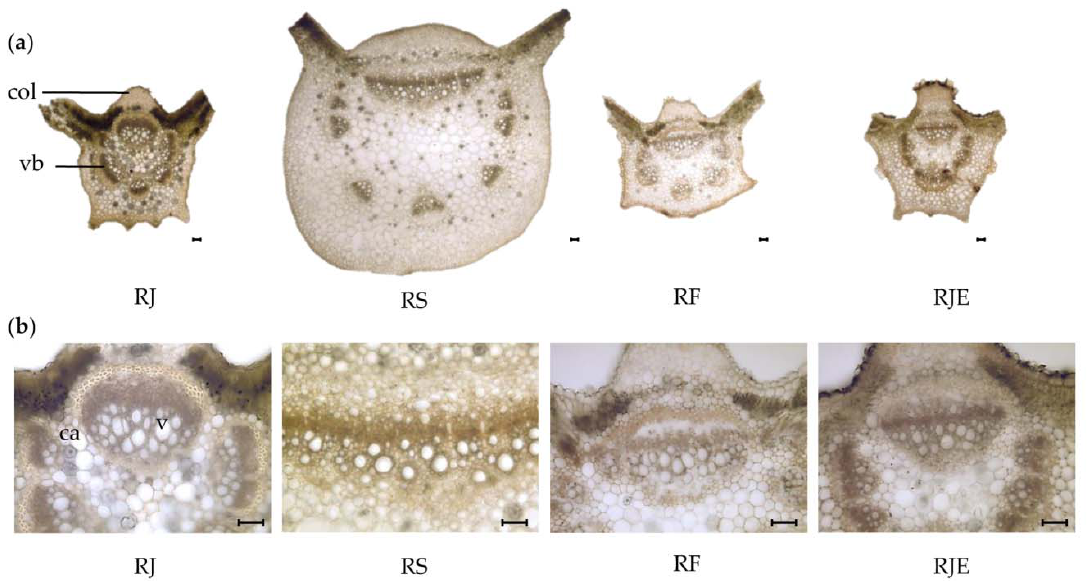
Figure 2. Photomicroscopic data of the midrib from four Reynoutria plants: ( a ) transverse section of the midrib; ( b ) Transverse section of a vascular bundle located at the center of the midrib. The black bars mean 100 µ m. ca : druse; col : collenchyma cell; vb : vascular bundle; v : vessel. Table 2. Anatomical characteristics of the midrib from four Reynoutria plants. Parameters RJ